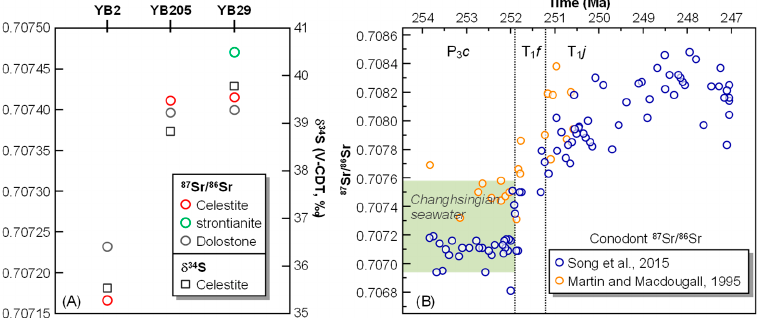
Figure 8. Comparison of 87 Sr/ 86 Sr values for celestites, strontianites, and host dolostones from P 3 c in the YB gas field ( A ) and contemporaneous seawater ( B ). The δ 34 S values of celestites are also shown in A . The 87 Sr/ 86 Sr values of Late Permian and Early Triassic seawater are referred to in Martin and Macdougall [56] and Song et al. [57]. Minerals 2022 , 12 , x FOR PEER REVIEW (0.707168~0.707471) in the YB gas field are all in the range of the 87 Sr/ 86 Sr values of the contemporaneous seawater (0.70694~0.70758) [56,57] and are significantly different from